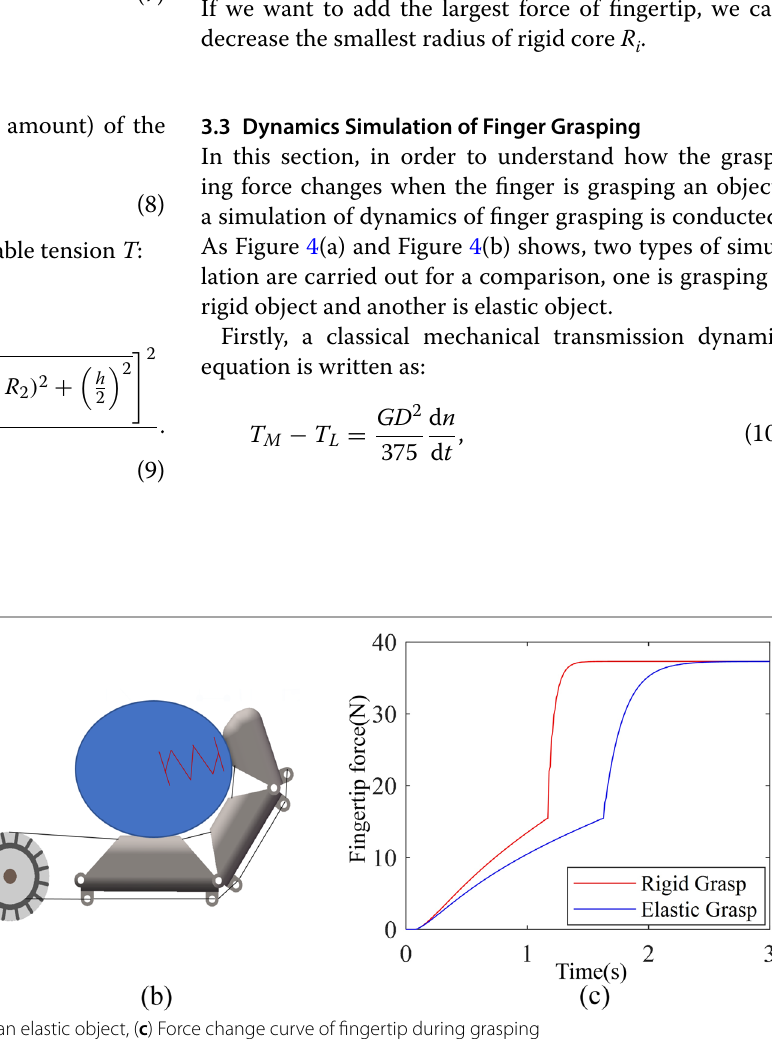
Figure 4 ( a ) Grasping a rigid object, ( b ) Grasping an elastic object, ( c ) Force change curve of fingertip during